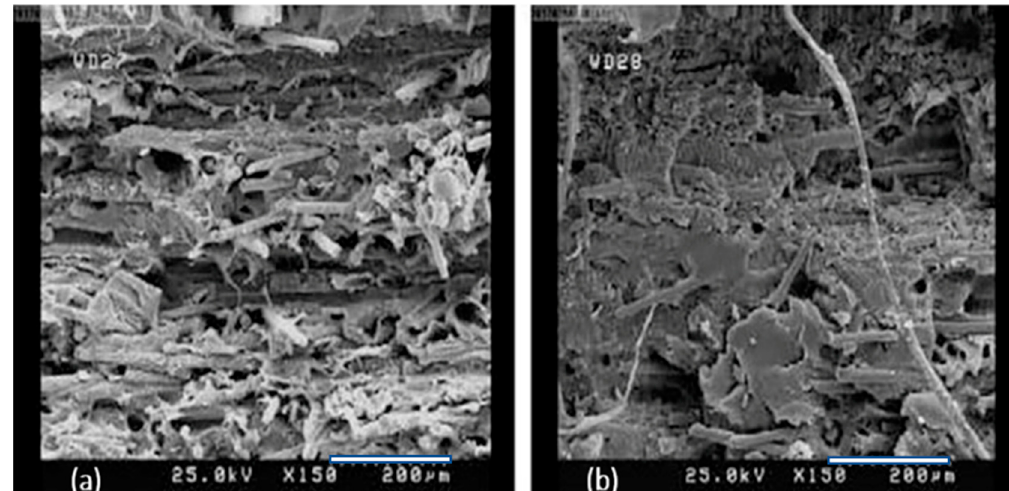
Figure 3. Scanning electron microscopy (SEM) images of the specimens manufactured using ( a ) 3D printing and ( b ) CM methods [33]. These images help to illustrate the differences in interlayer adhesion of 3D printed samples compared to that prepared using CM process.